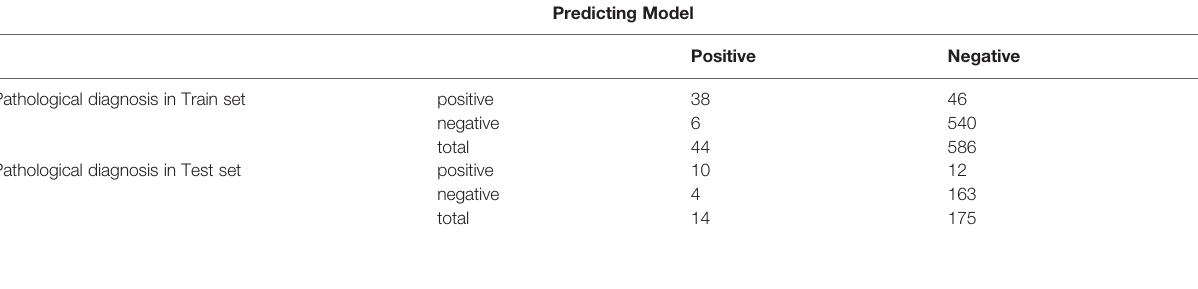
TABLE 4 | The predictive model and pathological diagnosis for skip metastasis in both training and validation